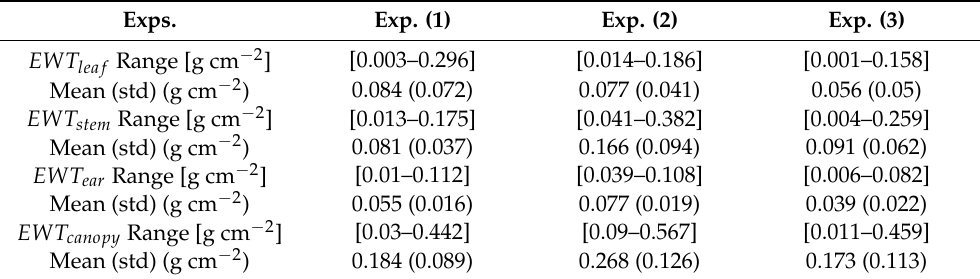
Table 5. Statistics (range, mean, standard deviation) for in situ measured EWT leaf , EWT stem , EWT ear and EWT canopy .